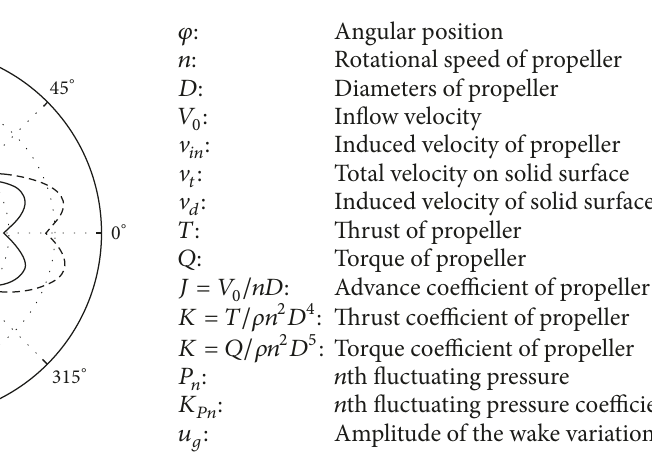
Figure 21: Comparison between the overall two-dimensional dis- tribution of the fluctuating pressure of CRP (solid line) and that of single propeller (dash